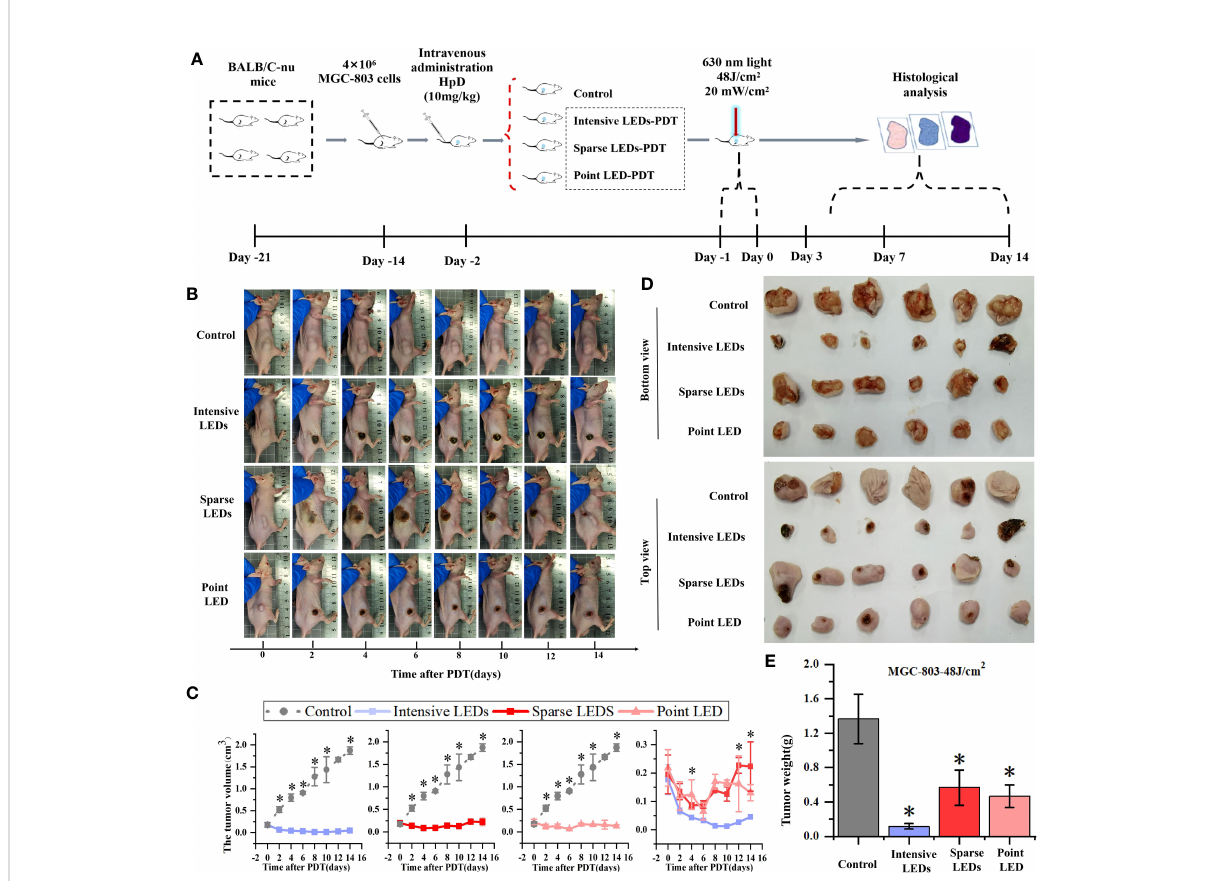
FIGURE 8 Effect of PDT mediated by different light fi elds on MGC-803 tumor-bearing mice. (A) Timeline of the PDT procedure. (B) Photographs of the mice at different days after intensive LED-PDT, sparse LED-PDT, and point LED-PDT. (C) Evolution of tumor volumes after PDT. (D) Photographs of resected tumors 14 days after PDT. € Volumes of resected tumors 14 days after PDT. (Mean ± SD, *P < 0.05 by one-way ANOVA, n = 3 mice for (C) , n = 6 mice for (E)